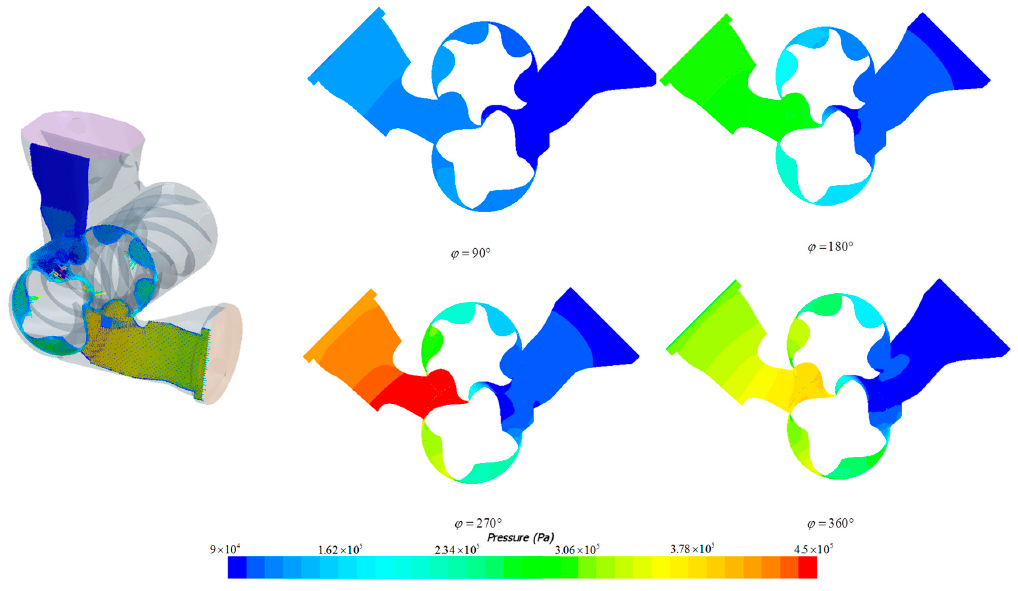
Figure 10. Cross-section of the pressure distribution in the vicinity of the discharge port.